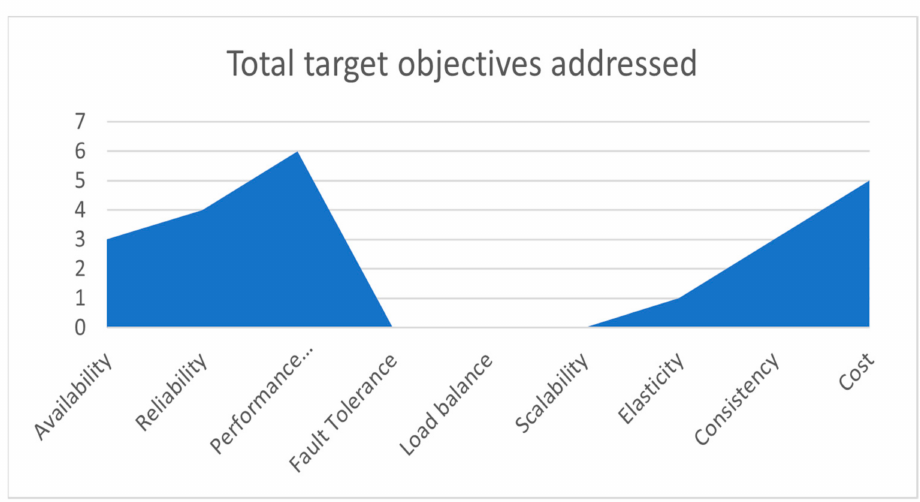
Figure 5. Total target objectives addressed in this research.